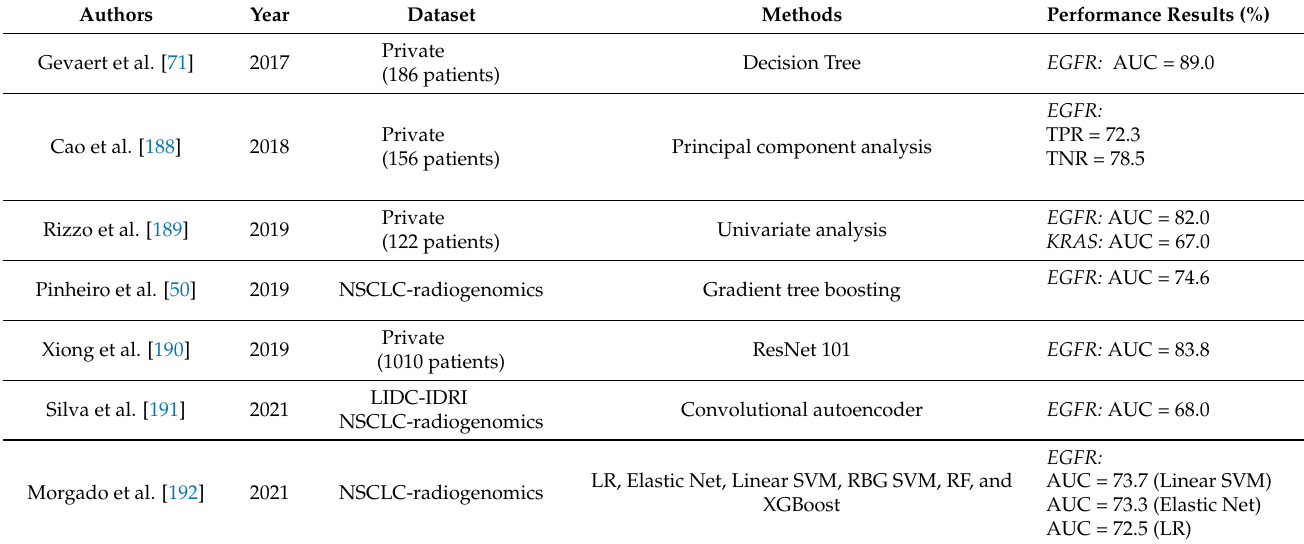
Table 7. Overview of published studies regarding predictive models for gene mutation status based on nodule and extra nodule features